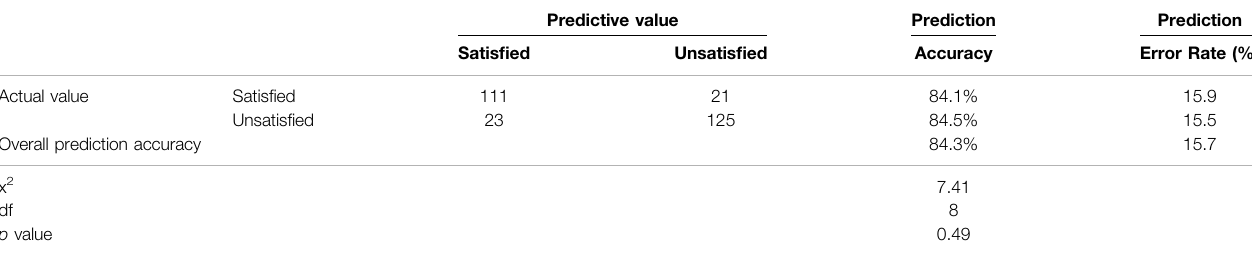
TABLE 4 | Summary of the binary regression prediction accuracy and the HL test